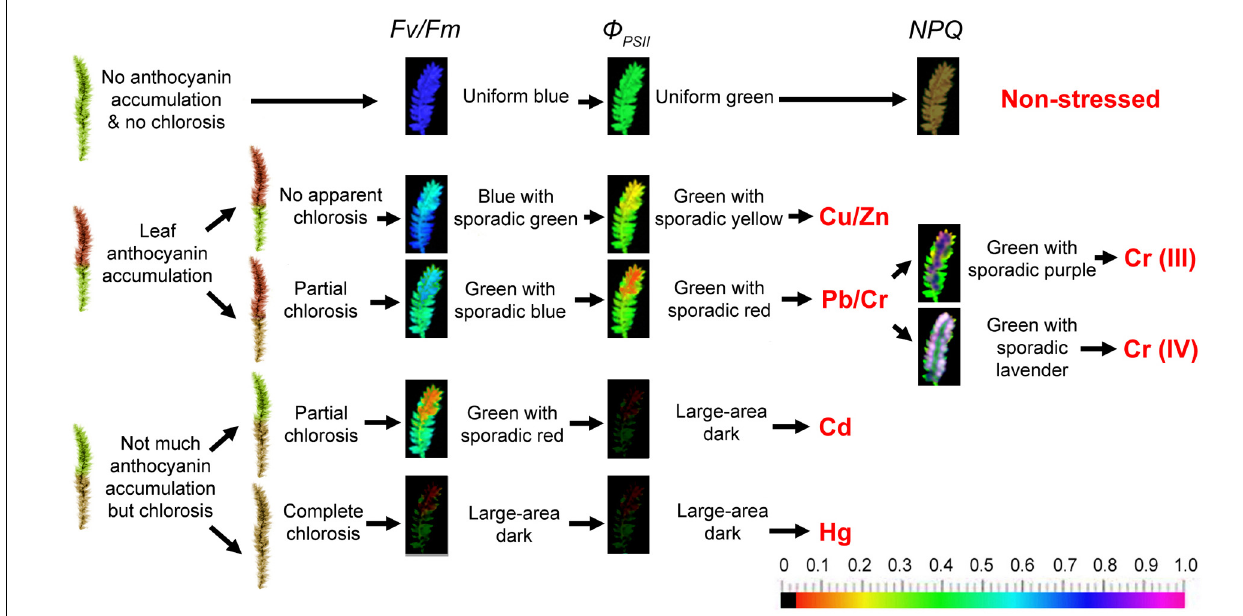
FIGURE 1 | Putative heavy metal estimation criteria of moss phenotype and chlorophyll fluorescence imaging. The moss was cultured in distilled sterile modified Mohr medium